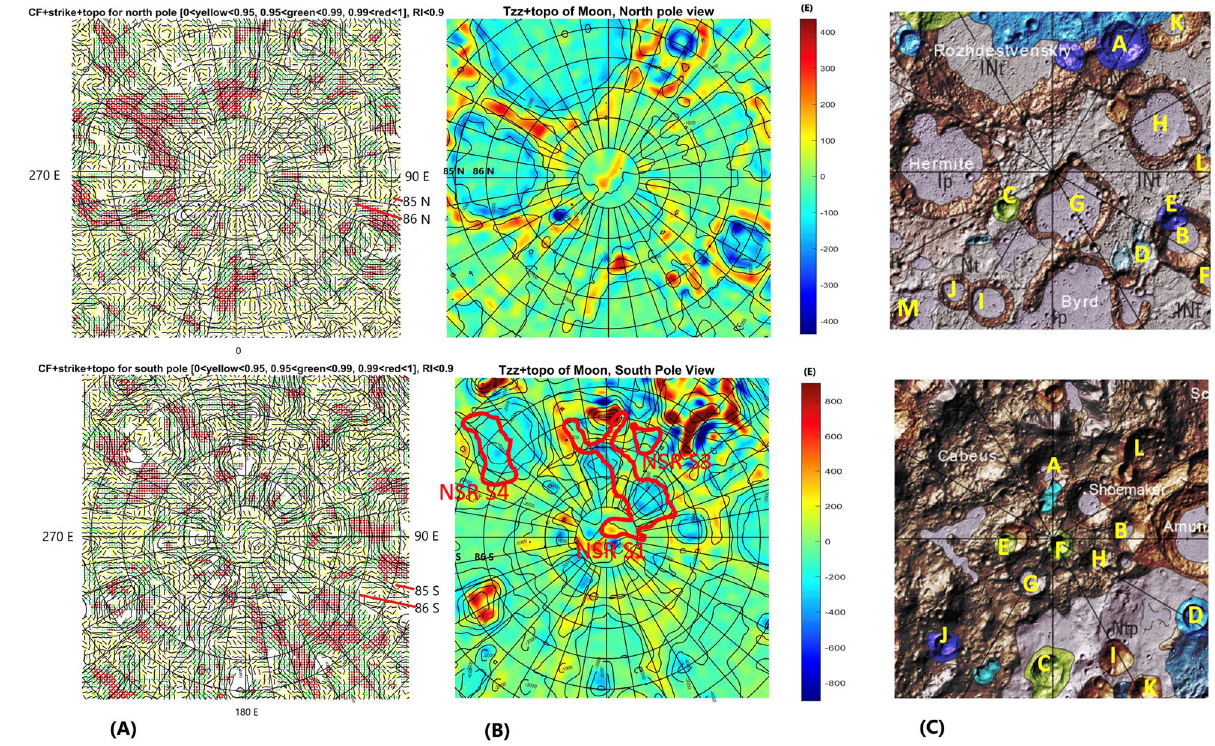
Figure 2. Geophysics, topography, and geological subunits of the Moons polar regions. ( A ) Gravity comb factor (CF) plotted for ratio I < 0.9 (see Eq. (2) and definition of CF in Supplementary information). The color legend identifies degree of alignment of strike angles (also Figs. 3, 4); ( B ) Gravity second derivative T zz [E] along with topography [m]. Three areas outlined by red lines and labelled with NSR S1, NSR S3, and NSR S4 are